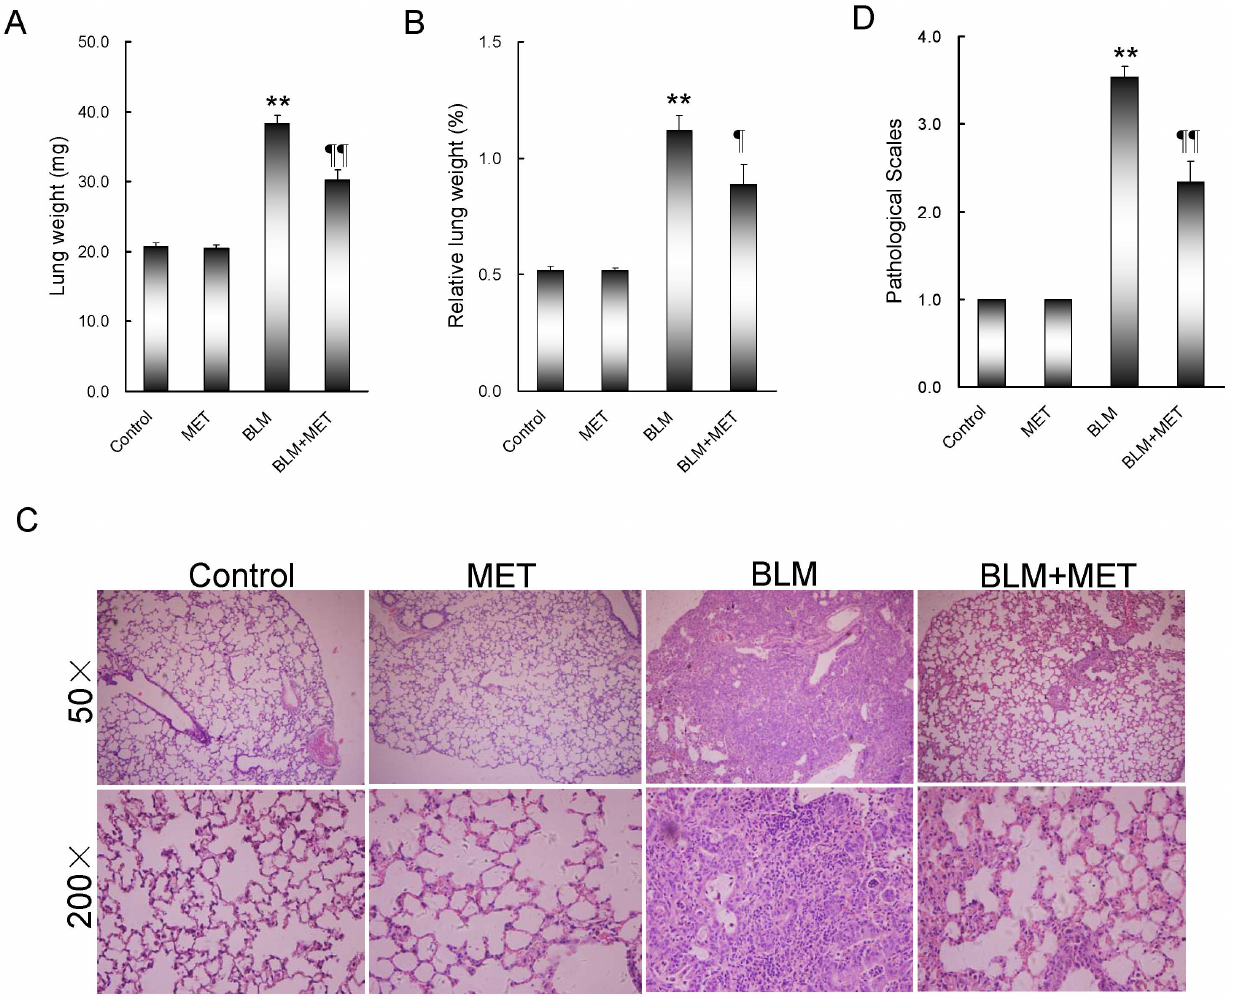
Figure 1. The effects of melatonin on BLM-induced pathohistological damage. All mice except controls were intratracheally injected with BLM (5.0 mg/kg). In BLM + melatonin group, mice were i.p. injected with melatonin (5 mg/kg) daily. Lungs were collected at 21 days after BLM. Lungs were weighed. (A) Absolute lung weight. (B) Relative lung weight. (C) Lung cross sections were stained with H & E. Original magnification: 50 6 (upper) and 200 6 (lower). (D) Pathohistological scores were evaluated according to pulmonary inflammation. All data were expressed as means 6 SEM (n=12). ** P , 0.01 as compared with control group. ` P , 0.05, `` P , 0.01 as compared with BLM group.